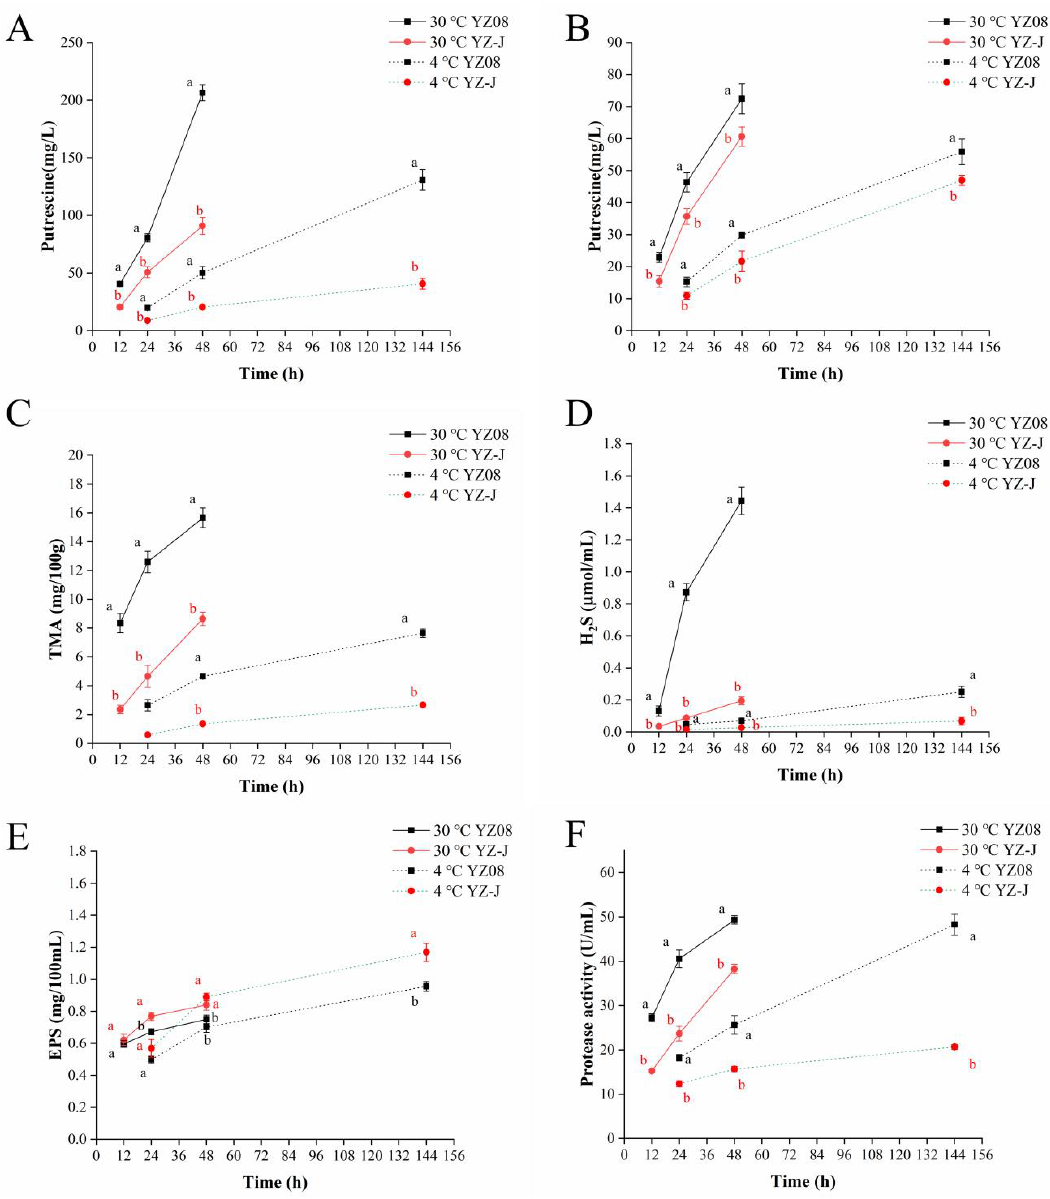
Figure 7. Changes in the putrescine ( A ), cadaverine ( B ), TMA ( C ), H 2 S ( D ), exopolysaccharide ( E ) and protease activity ( F ) produced by S. putrefaciens YZ08 and YZ-J during storage at 4 and 30 ◦ C. The significance analysis for different strains at the same culture time and temperature was performed. Different lowercase letters indicate significant differences ( p < 0.05).